Question: What form of chart is displayed?
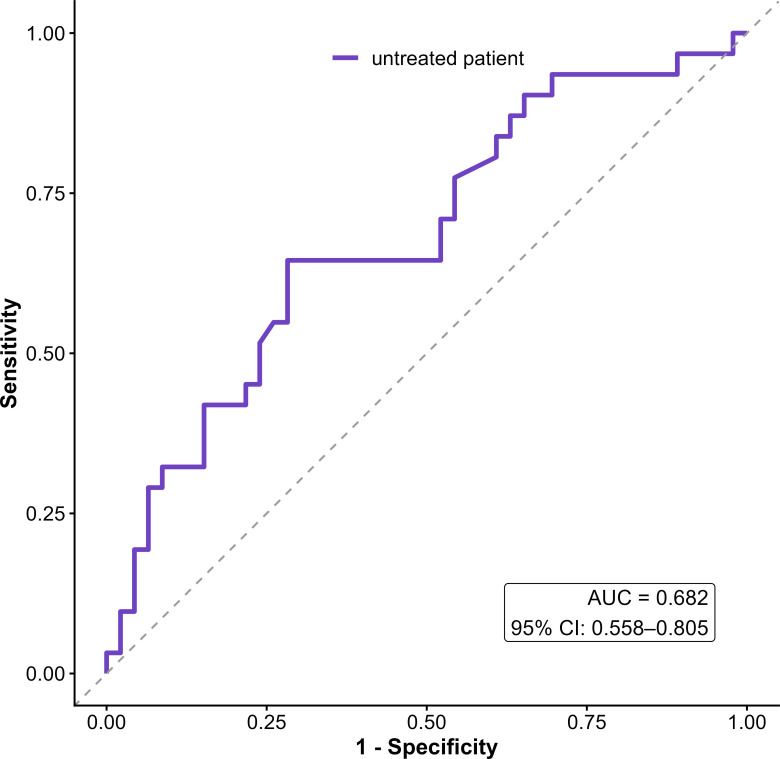
Answer: line